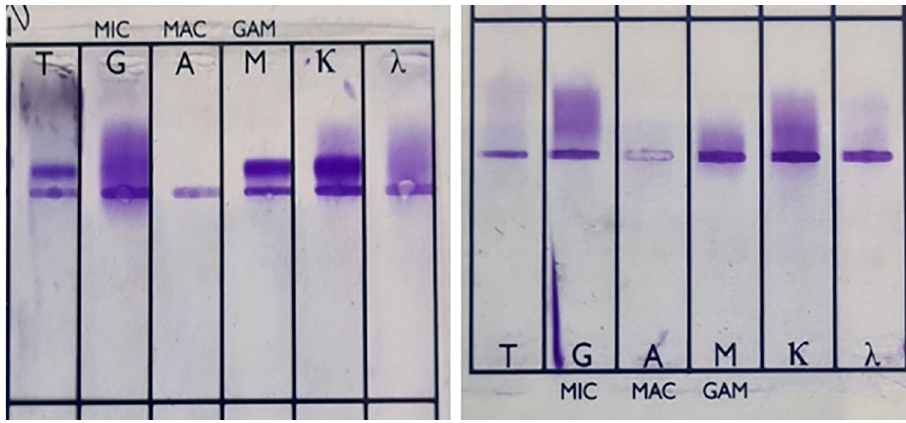
Figure 3. Patterns of immunoglobulin identification of the hypocryoglobulimemic precipitates by gel electrophoresis and immunofixation. Left side: example of type II hypocryoglobulin with policlonal IgG and monoclonal IgM-k. Right side: example of type III hypocryoglobulin with policlonal IgG and policlonal IgM. The grouping of gels different parts of from different gels. Full-length gels are included in a